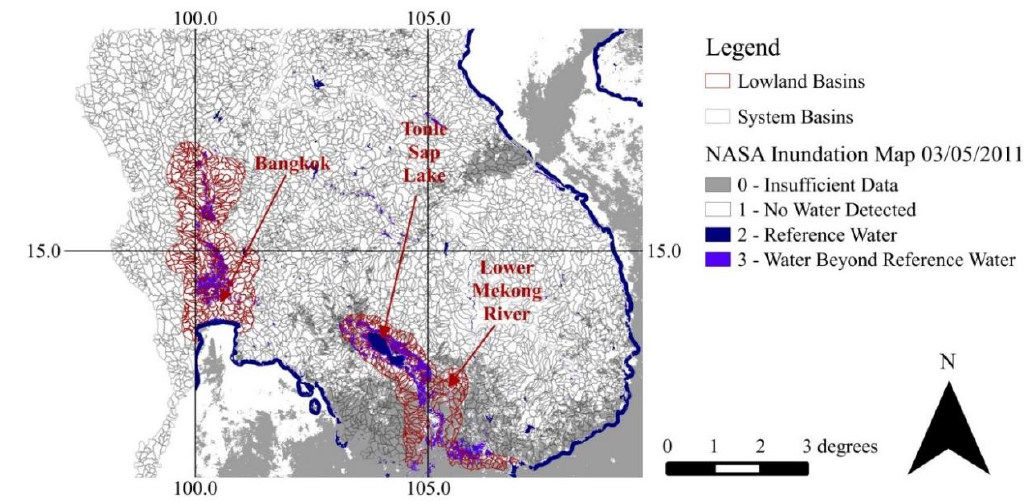
Figure 9. Mekong River Commission (MRC) Flash Flood Guidance (FFG) basins (n = 1046) within a 30 km buffer of regional low-lying areas.